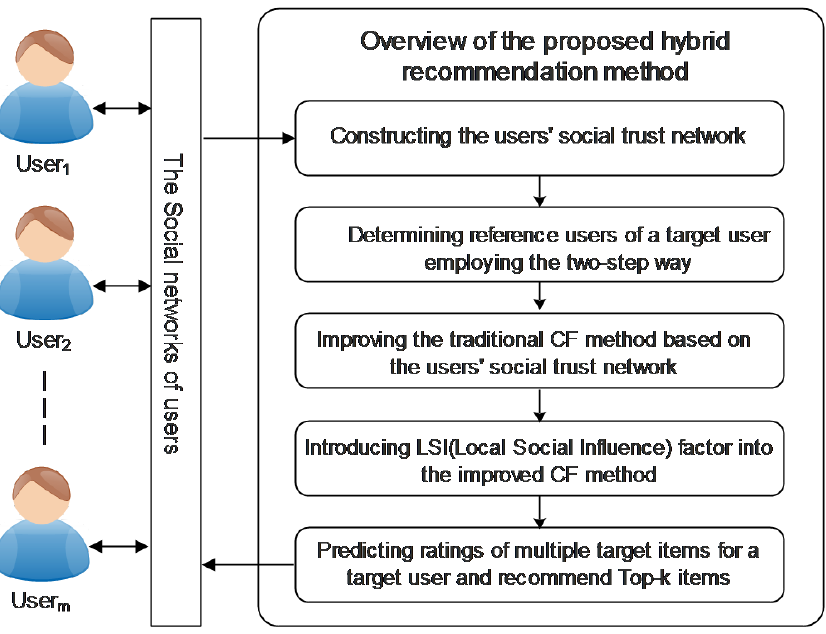
Figure 1. Overview of the proposed hybrid recommendation